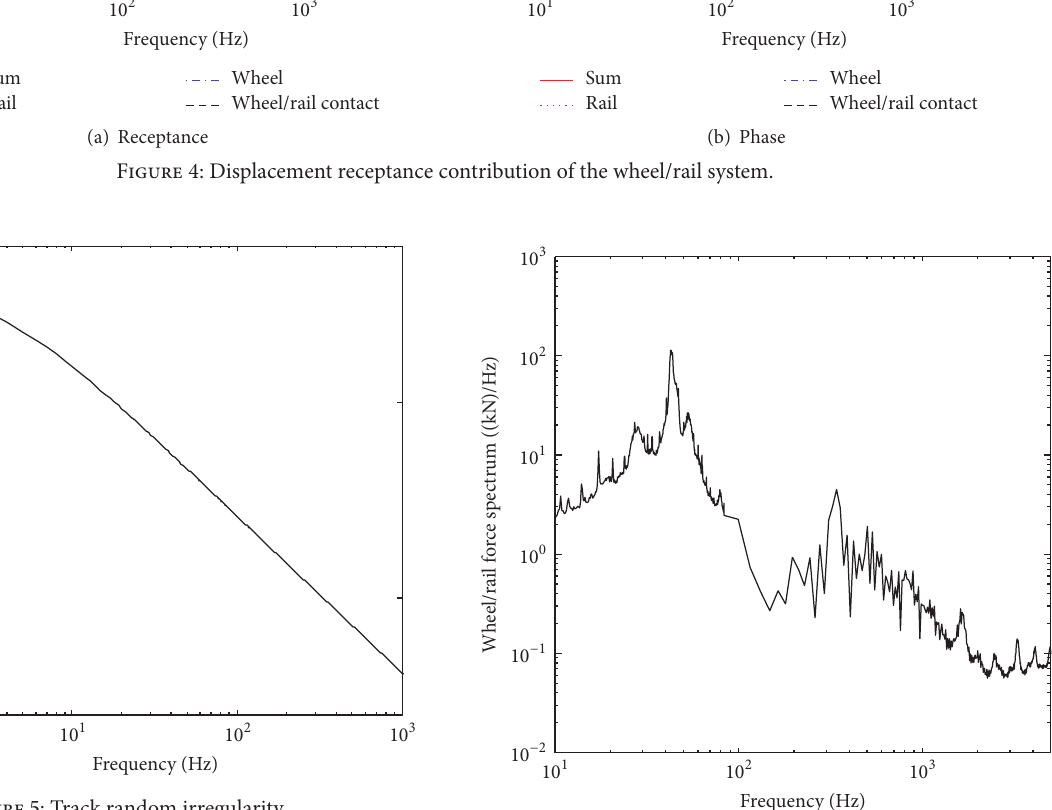
of wheel/rail force reaches maximum at 54 Hz and second large at 380 Hz. Above 1000 Hz, the wheel/rail force has some peaks but the corresponding vibration energy is